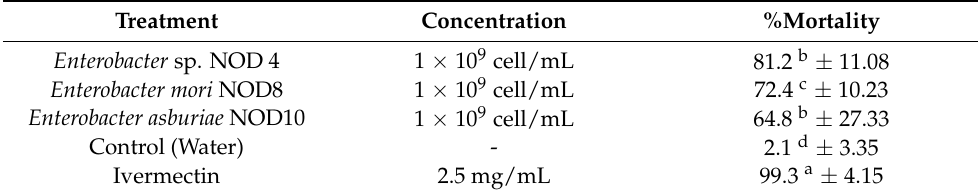
Table 2. In vitro evaluation of Enterobacter strains against Panagrellus redivivus . Treatment